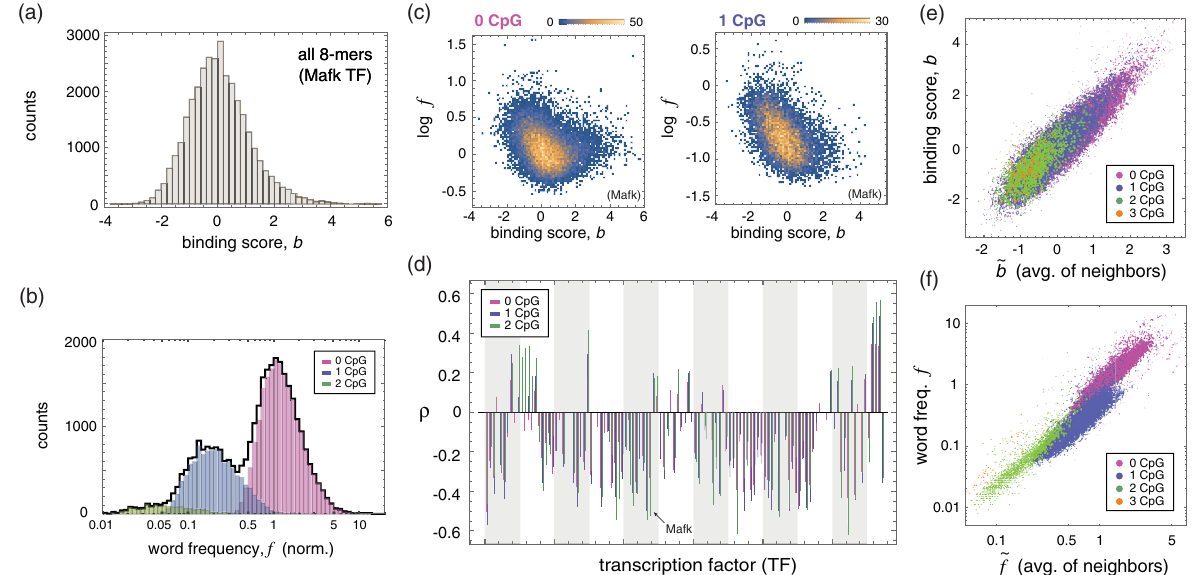
FIG. 1. Mouse genomic binding landscape and in vitro DNA binding measurements. (a) Distribution of binding scores b i for the Mafk TF over all 8-mer words i . (b) Distribution of 8-mer word frequencies f i in mouse introns (black curve); f i are shown normalized with respect to expectation based on genome-wide nucleotide composition. Words are shown as separate histograms according to their CpG counts (colored bars). (c) Correlation of b i and log f i for the Mafk TF in separate CpG categories. Color indicates density of points. (d) Correlation coefficients (Spearman ’ s ρ ) of b i versus f i are shown for each mouse TF separately computed conditioned on word CpG content. Bars are shown only for statistically significant correlations, with p value < 10 − 6 . (e) Binding scores of words ( b i ) are ~ b ρ ð b; ~ b Þ ¼ 0 . 87 . (f) Correlation correlated with the average binding score of their mutational neighborhoods ( i ); results shown for Mafk, ~ f i for mouse introns; words are colored according to CpG content, and frequencies are normalized as in of f i and i over all 8-mer words (b) and